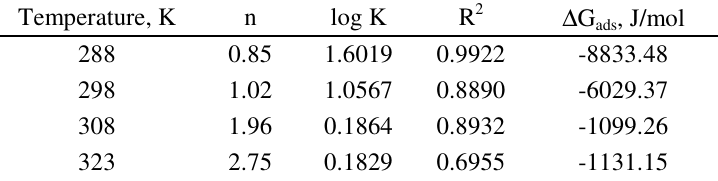
Table 2. Freundlich parameters for the adsorption Pb 2+ onto human